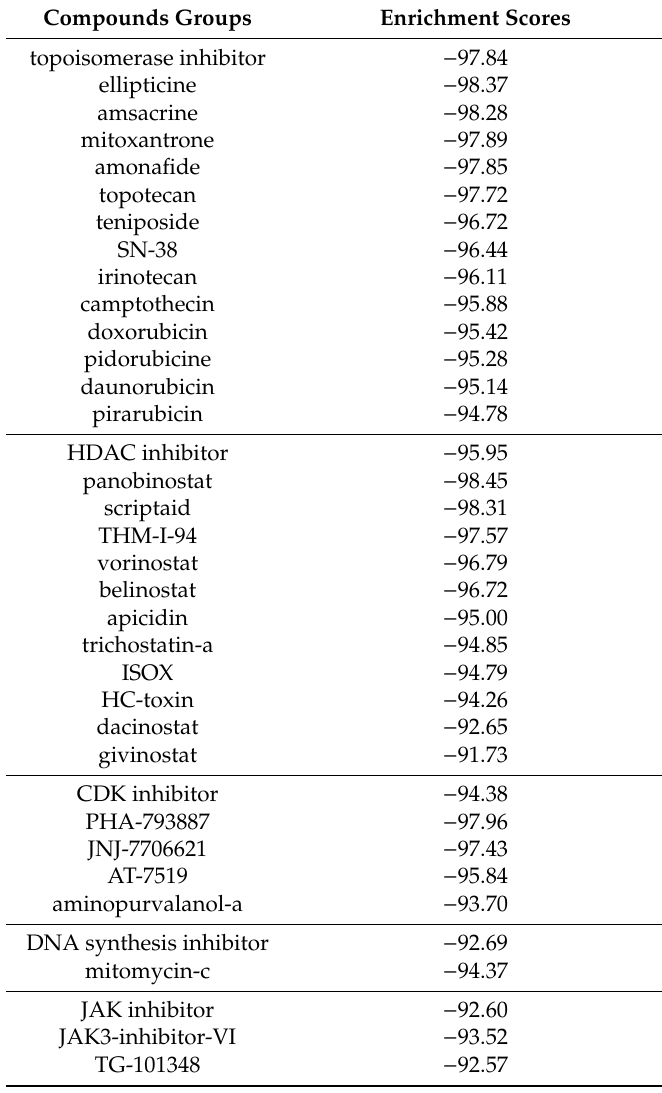
Table 3. Compounds belonging to classes identified by CMap as most opposing to gene expression changes resulting from angiosarcoma.